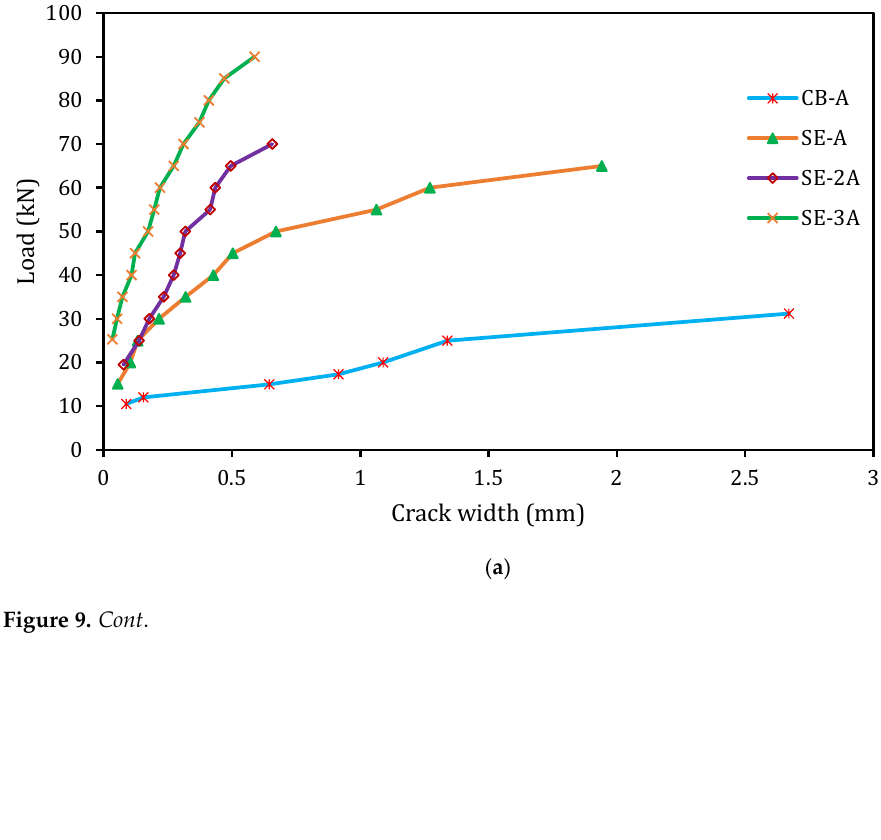
Table 3. Tested results for cracks.